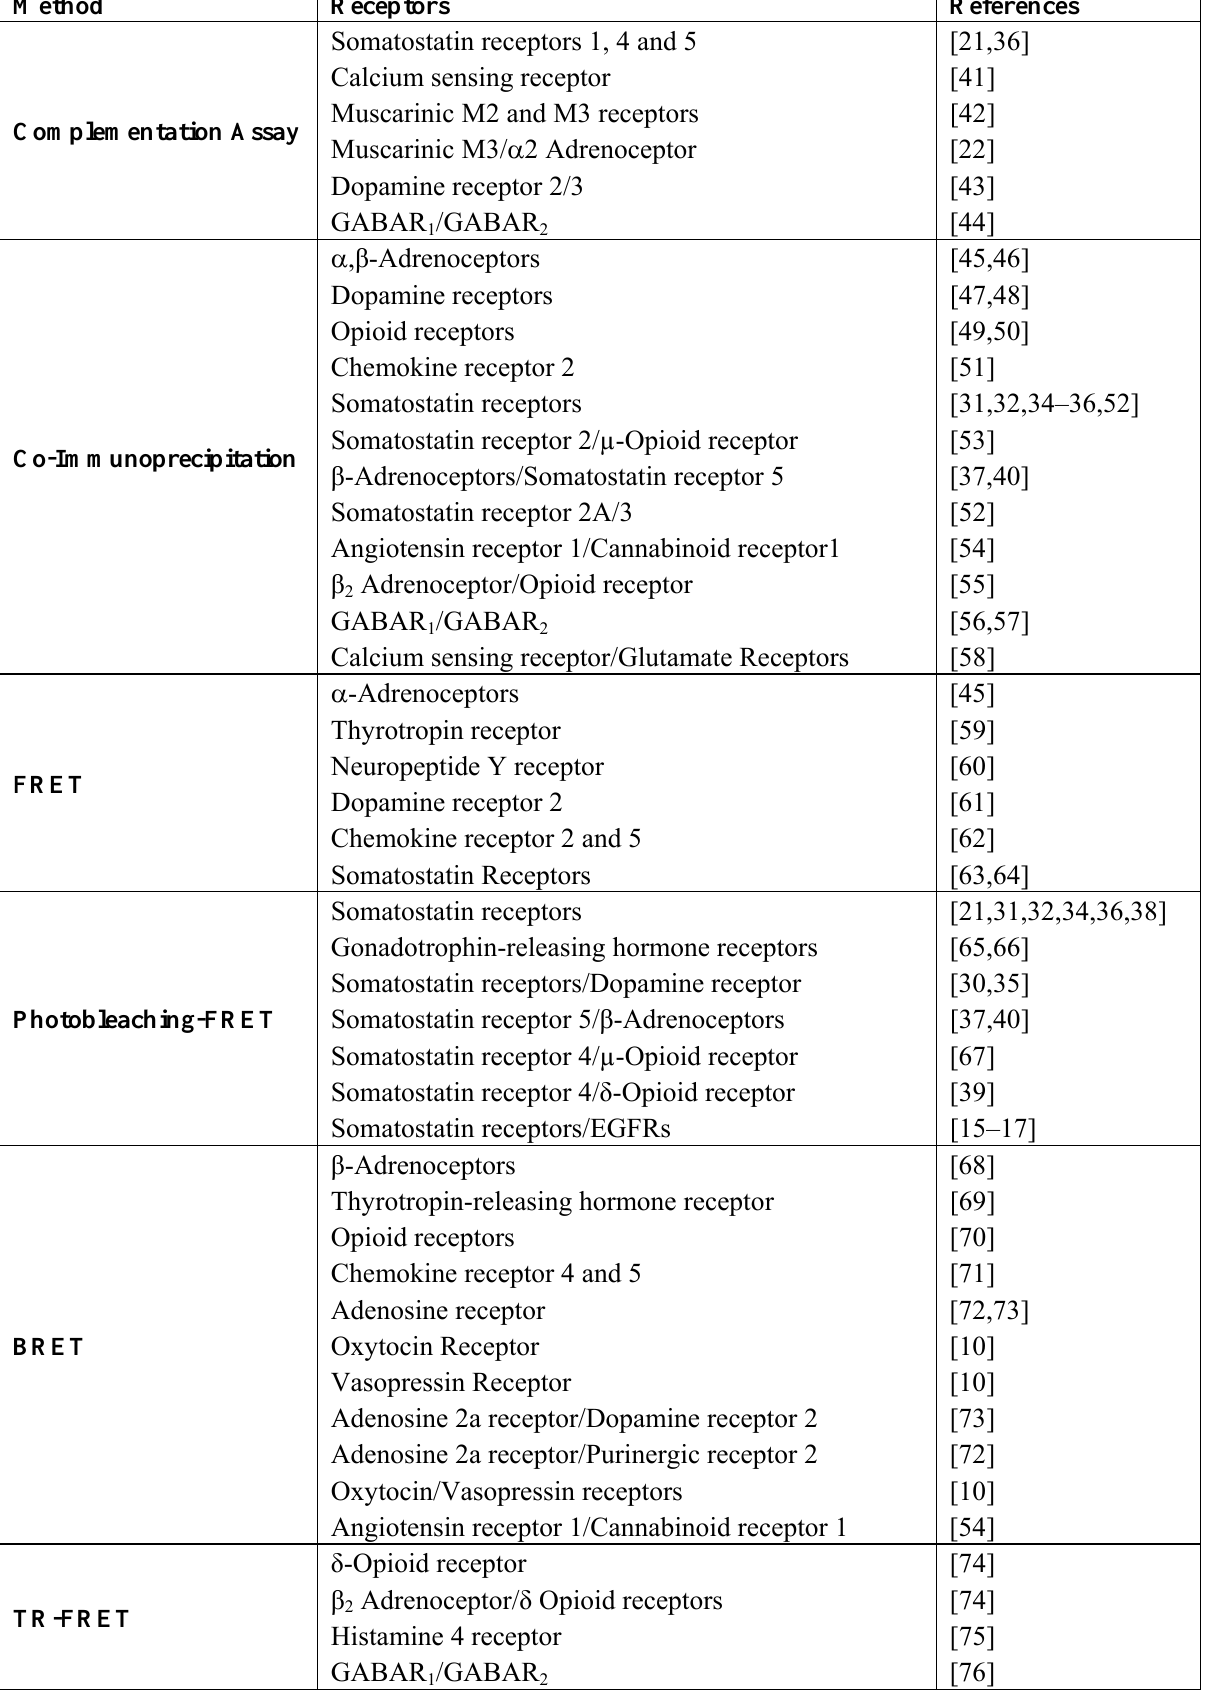
Table 1. The list of techniques used to determine homo- and/or heterodimerization.